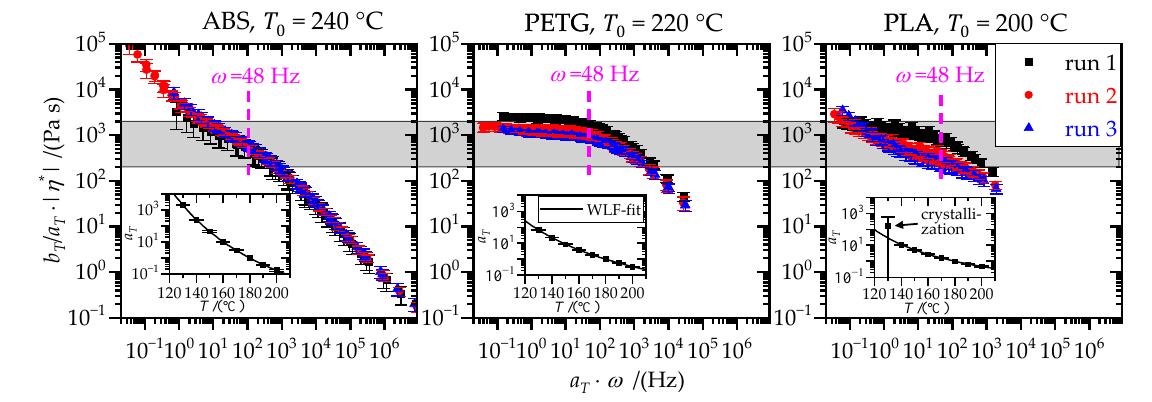
Figure 6. Frequency dependence of the complex viscosity, η *, at a reference temperature T 0 of 240 °C (ABS), 220 °C (PETG) and 200 °C (PLA), respectively, for three subsequent measurement runs. The target viscosity range (gray area) and the shear rate (48 1/s) during the ME process are indicated. Horizontal shift factors, a T , with corresponding WLF-fit are shown for the first run. Comparing the three polymers in terms of modulus, G ’ and G ” , or loss factor, tan( δ ), revealed pronounced differences, particularly in terms of the loss factor (cf. Figure 7). Especially for low frequencies, the loss factor, tan( δ ), and thus the viscous character of the polymer melt, was significantly higher for PETG than for PLA and ABS.